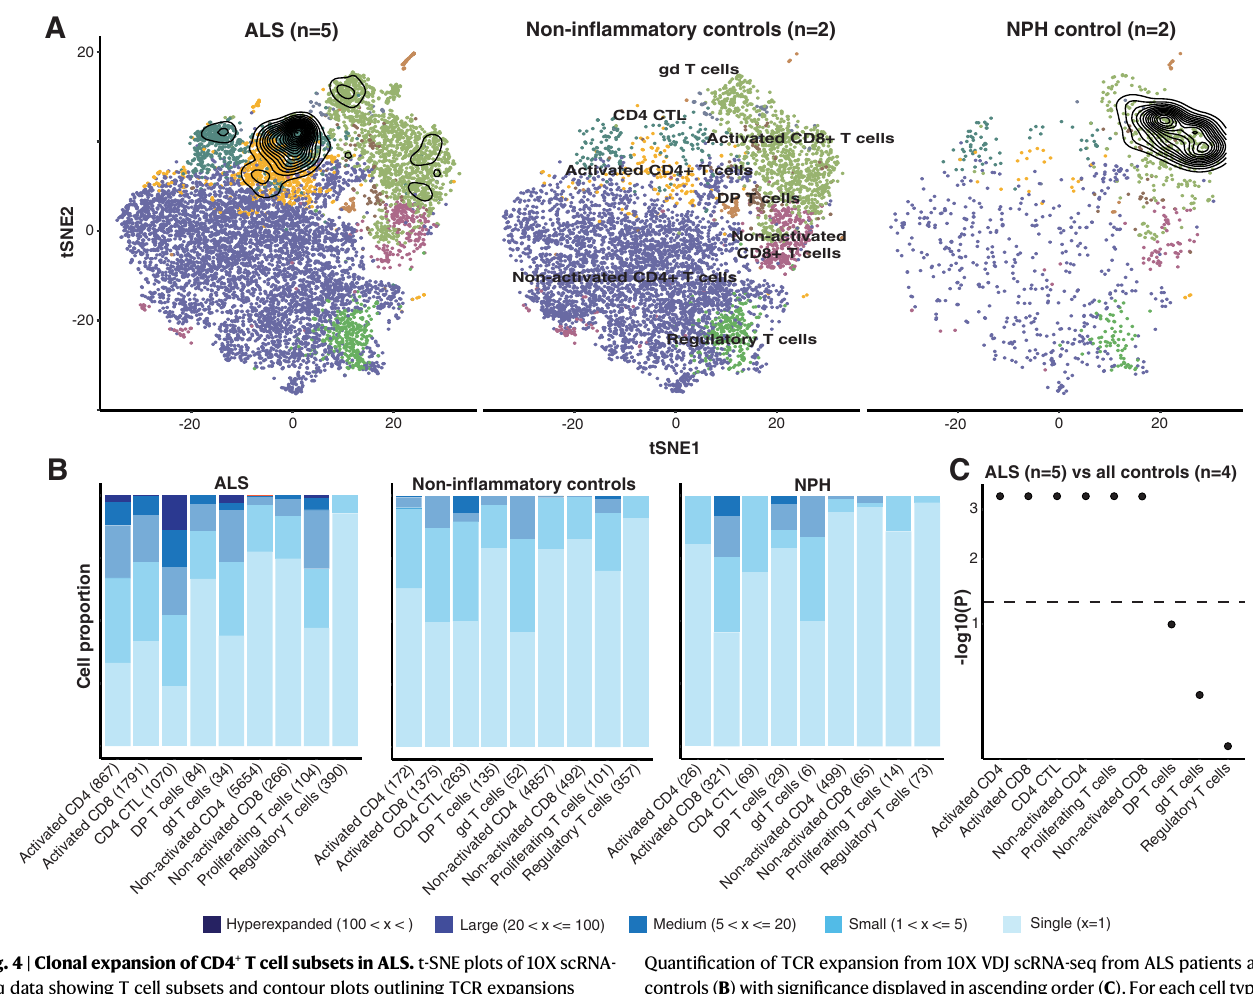
Quanti fi cation of TCR expansion from 10X VDJ scRNA-seq from ALS patients and controls( B )withsigni fi cancedisplayedinascendingorder( C ).Foreachcelltype, p values were calculated using Pearson ’ s Chi-squared test and Monte Carlo simula- tion with 2000